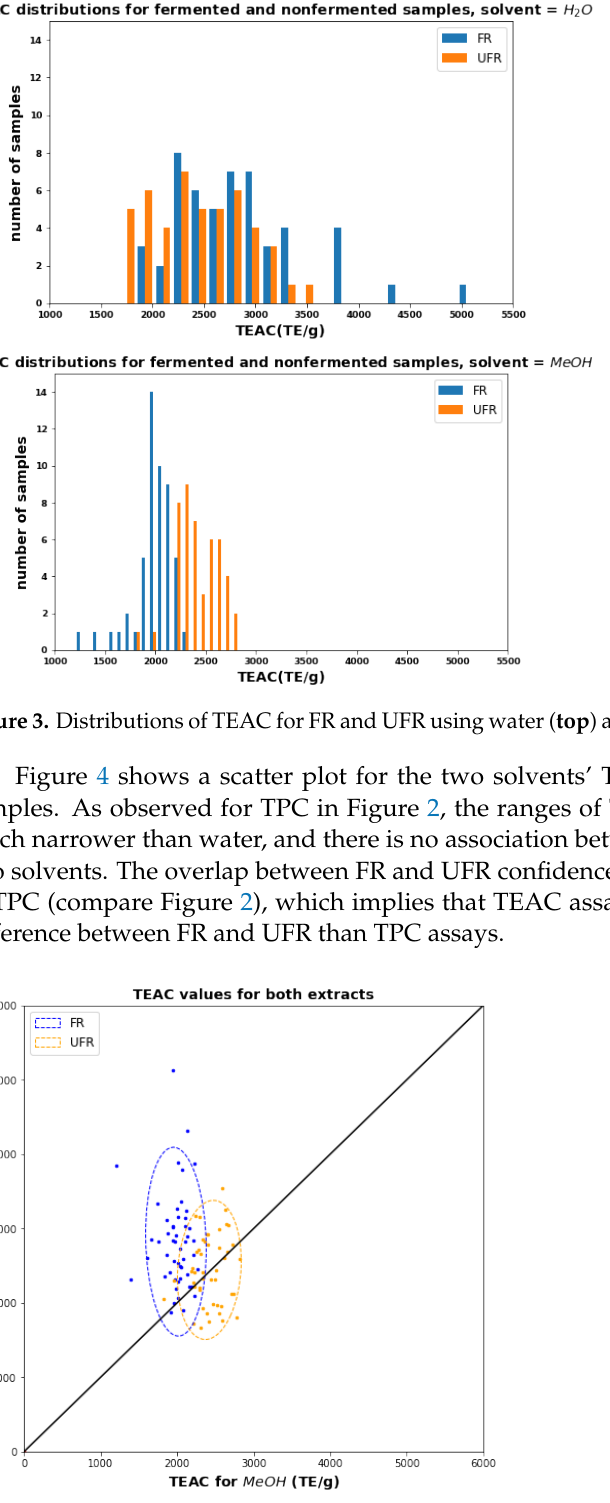
Figure 4. Scatter diagram showing FR and UFR TEACs for water versus